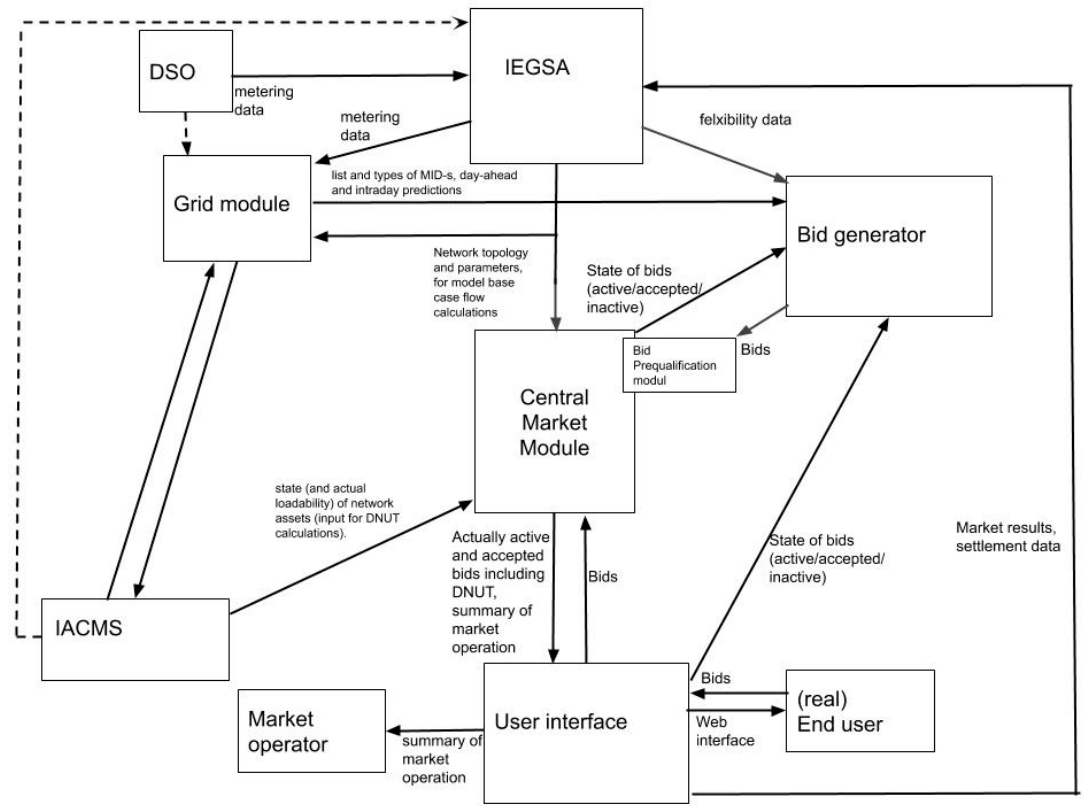
Figure 2. Sub-modules and their connection.